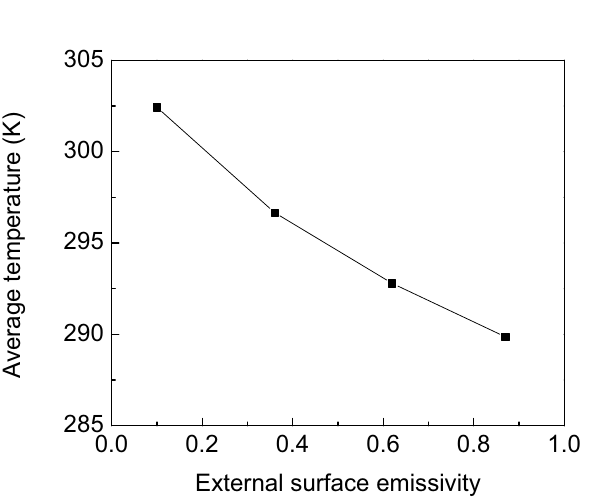
Figure 4. The influence of the external surface emissivity on the temperature of air channel.